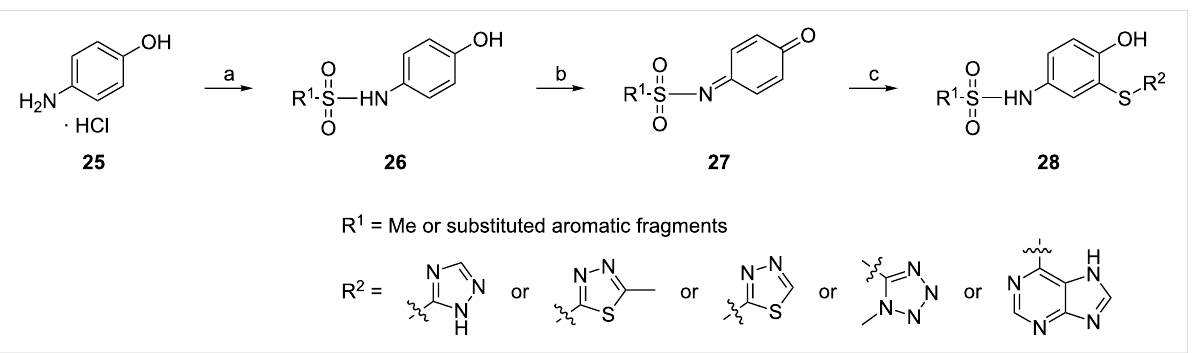
Scheme 6: Synthesis of 4-amino-2-sulfanylphenol derivatives. Reagents and conditions: (a) R 1 SO 2 Cl, pyridine, 0 °C; (b) NaIO 4 /SiO 2 , DCM; (c) DMF, R 2